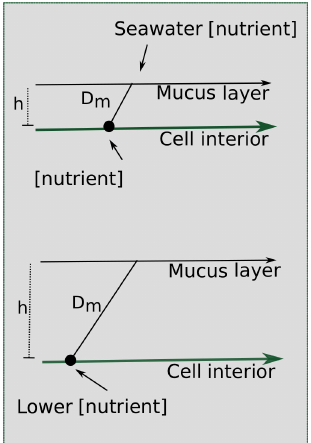
Figure 9. Scheme for the effect of a mucus layer on nutrient dif- fusion. h represents the height of the mucus membrane and D m represents the diffusion coefficient of the mucus. Assuming some diffusion constant for the nutrient through the mucus and the same starting seawater nutrient concentration, a thicker layer of mucus surrounding a cell in a colony would result in a lower concentration of nutrients experienced at the cell